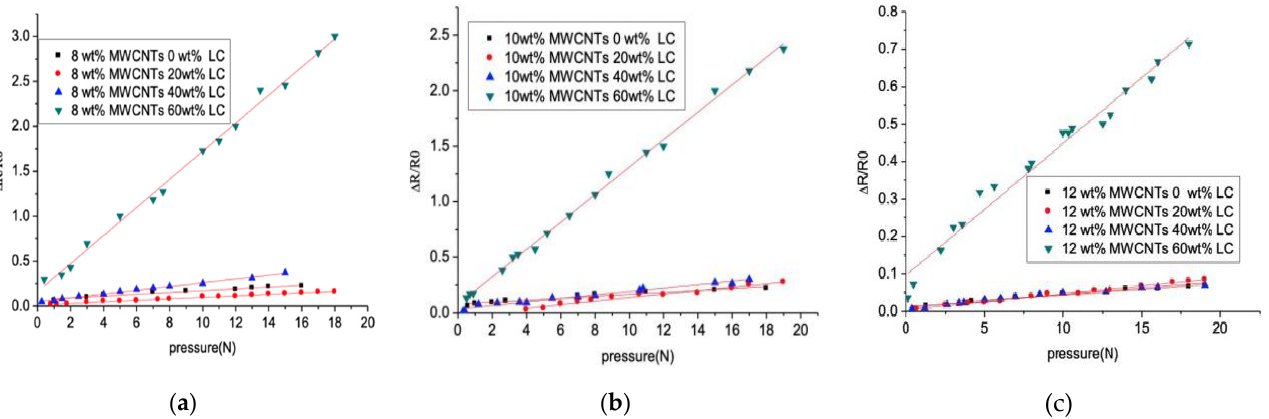
Figure 8. The relative resistance changes in the pressure range of 0–20 N with 0–60 wt% LC and MWCNTs of ( a ) 8 wt%; ( b ) 10 wt%; and ( c ) 12 wt%.